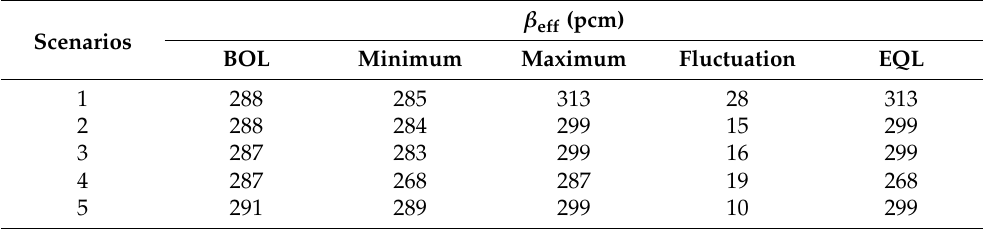
Table 6. The β eff for different